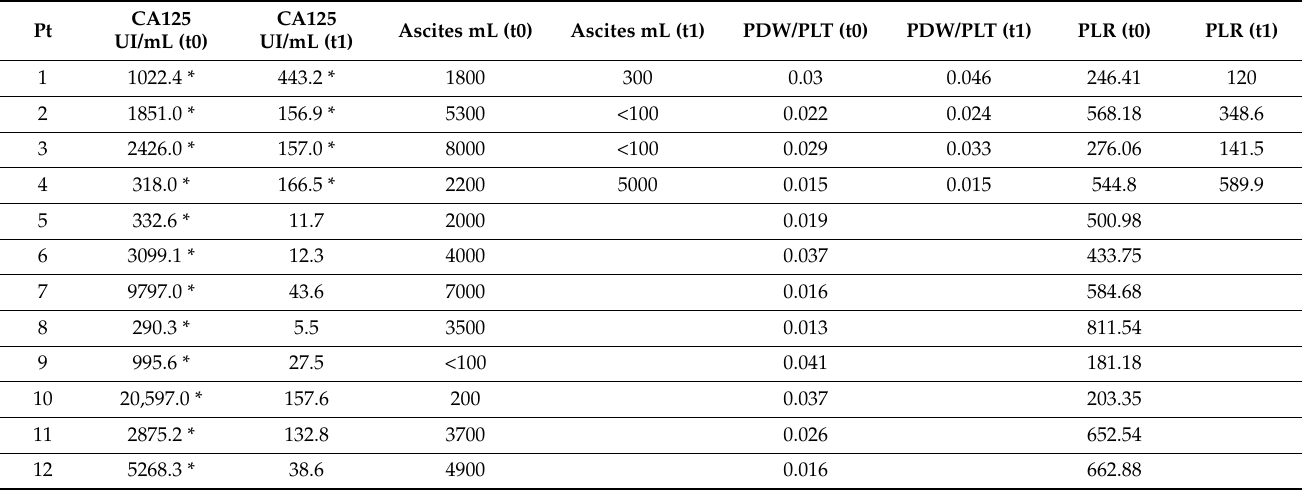
Table 1. Patient selection and clinical